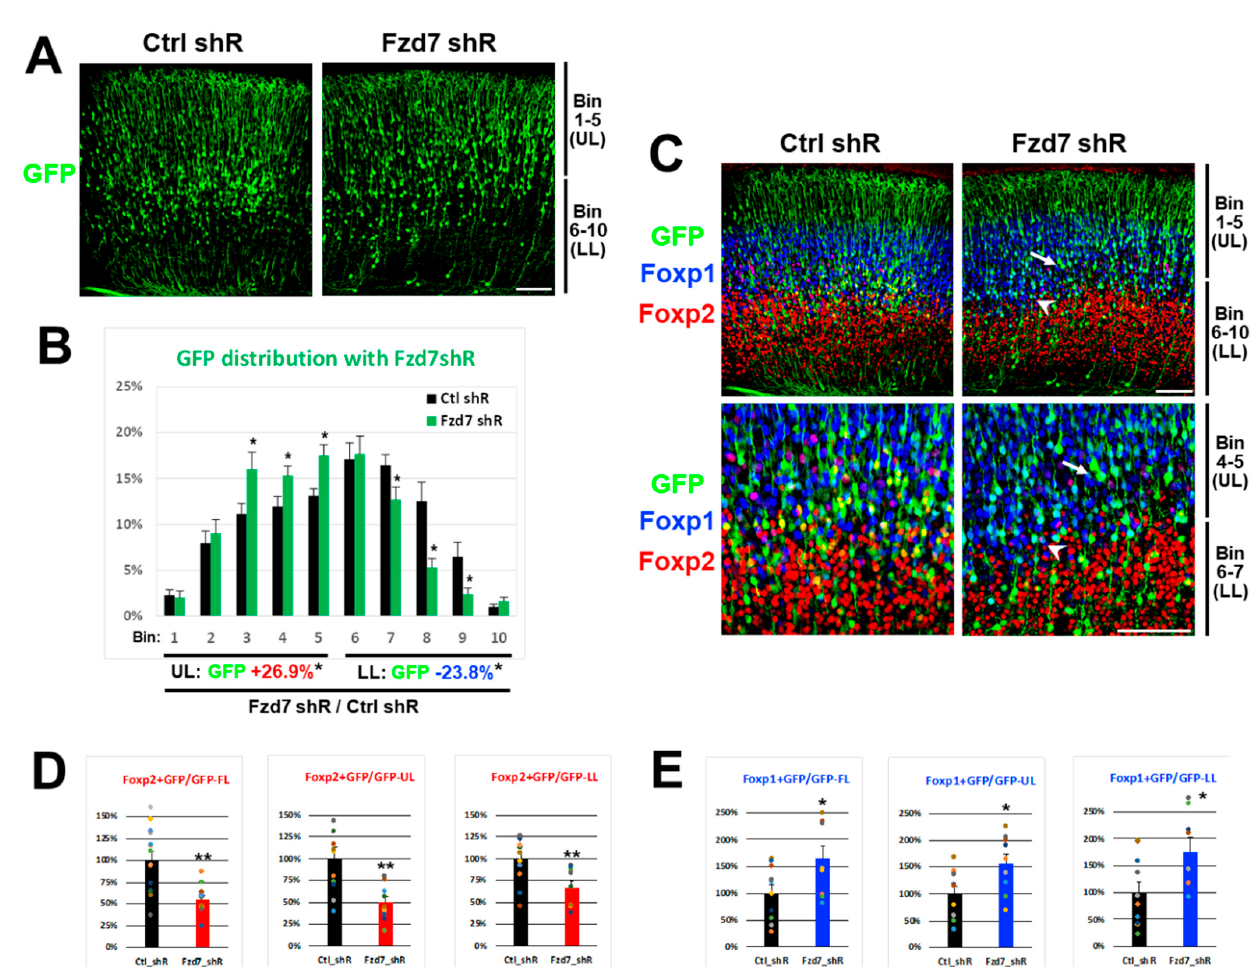
Figure 5. Foxp2 downregulation in UL and Foxp1 upregulation in LL with Fzd7 shRNA at P0 (E13–P0). ( A ) . IHC for GFP cells (green) in P0 neocortices electroporated in utero with Ctrl or Fzd7 shRNA at E13 ( n = 3 animals). Bin 1–5: upper layers (UL); Bin 6–10: lower layers (LL); scale bar: 100 µm. ( B ). Percentage (%) of GFP + cells in each bin from total 10 bins ( n = 13–15 pictures counted with total 1965–2500 GFP cells). GFP + cells in the upper layers (Bin 1–5) of Fzd7 shRNA neocortices increased up to 26.9% compared to Ctrl shRNA, while decrease of 23.8% was shown in the lower layers (Bin 6–10). *: p < 0.05. ( C ). IHC for GFP (green), Foxp1 (blue), and Foxp2 (red) in P0 neocortices. Arrow and arrowhead: the areas showing bigger change in Foxp2 and Foxp1 expression, respectively, which are shown with higher magnification images in the lower panel. ( D , E ). Quantification of Foxp2 ( D ) and Foxp1 ( E )-positive cells ( n = 8–14 pictures counted with total 1752–2358 GFP cells), normalized to the Ctrl shRNA (100%). Data represent the mean and SEM. FL; full layers (Bin 1–10); statistics: Student’s t -test; *: p < 0.05; **: p <